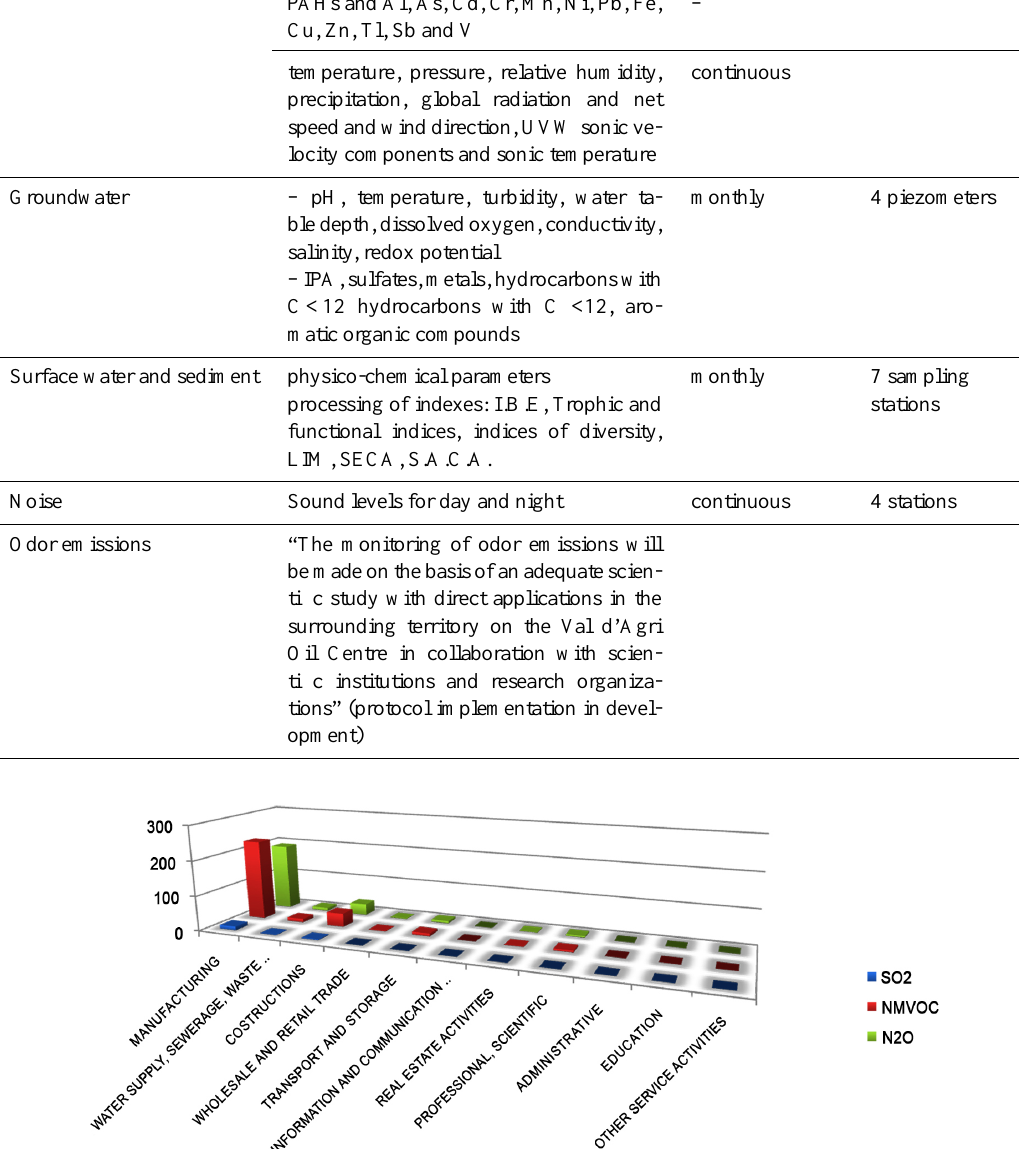
Figure 8. Local air pollutant emissions from energy processes by sector (kgyr − 1